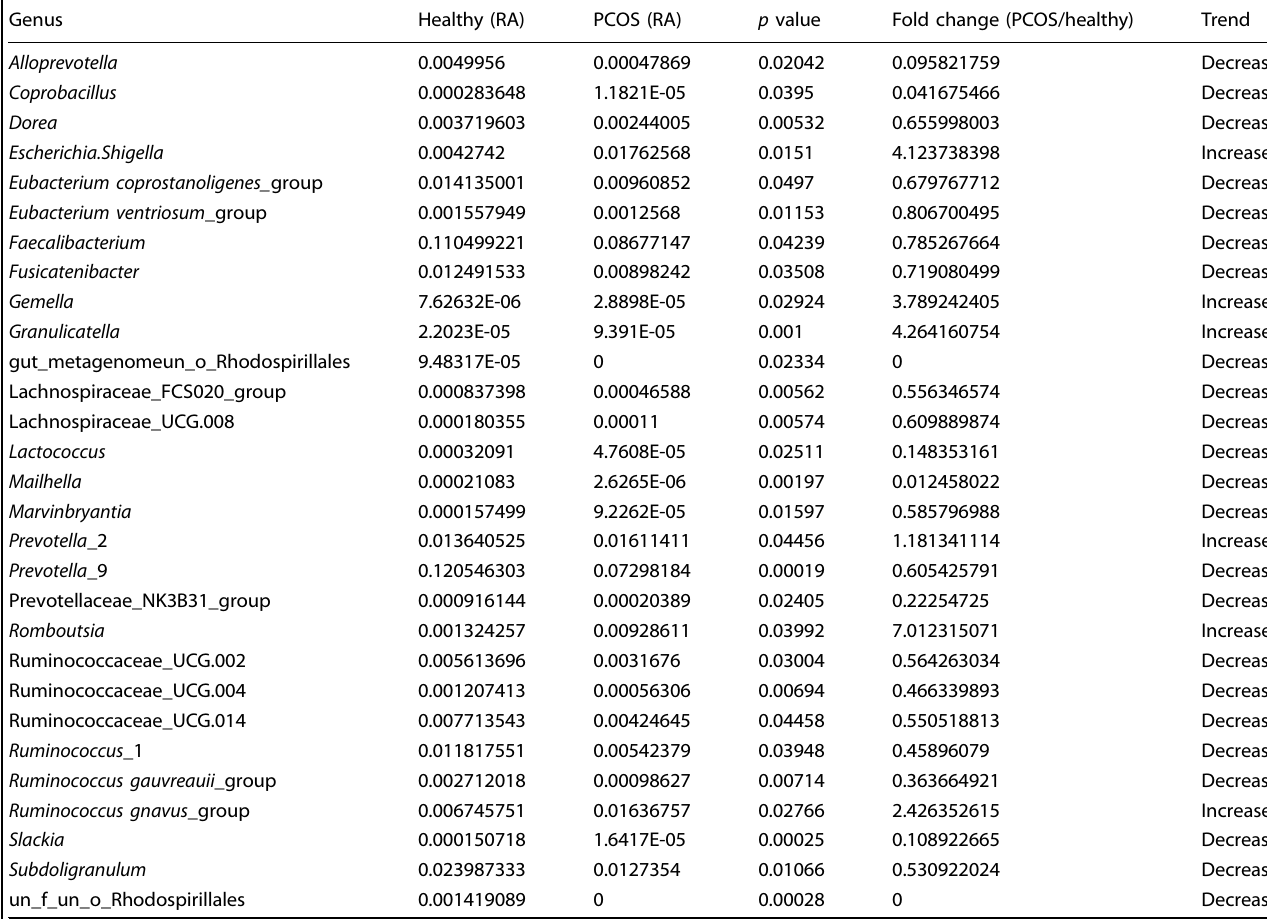
Table 2. Bacterial genus comparison between healthy and PCOS